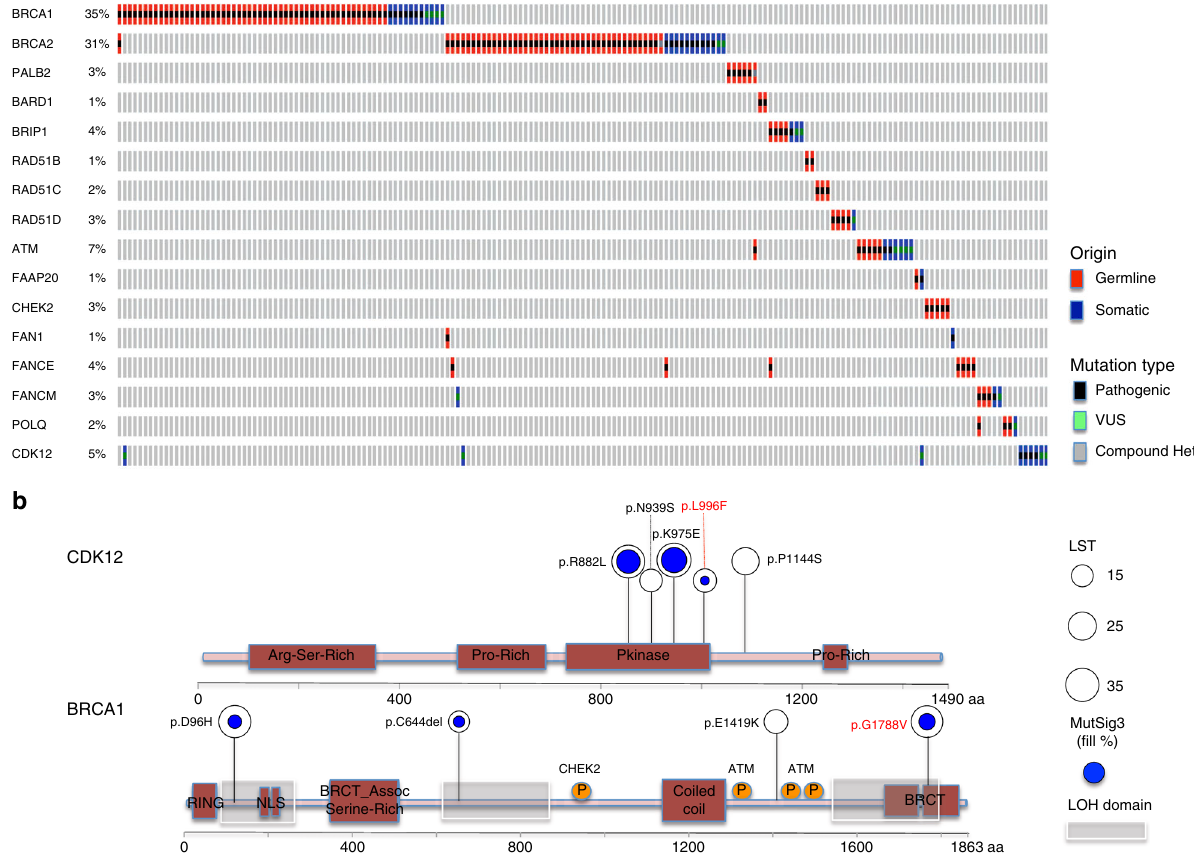
Fig. 3 Mutual exclusivity analysis of bi-allelic alterations in HR-related genes and reclassi fi cation of VUSs based on genomics information. a Bi-allelic pathogenic alterations are mutually exclusive using two different statistical tests ( p = 0.022, WExT, saddle point approximation of COMET; p = 0.025, permutation, methods). Inclusion of VUSs also demonstrates mutual exclusivity( p = 0.04, WExT). b VUSs in CDK12 and BRCA1 . Size of circle indicates LST scores, while the blue fi lling corresponds to the proportion of signature 3-related mutations. Interestingly, 3 of 4 BRCA1 VUSs occurred in regions enriched for loss of heterozygosity ( LOH ), and are associated with an increased likelihood of a functional de fi cit in HR 38 . Variants discussed in text indicated in